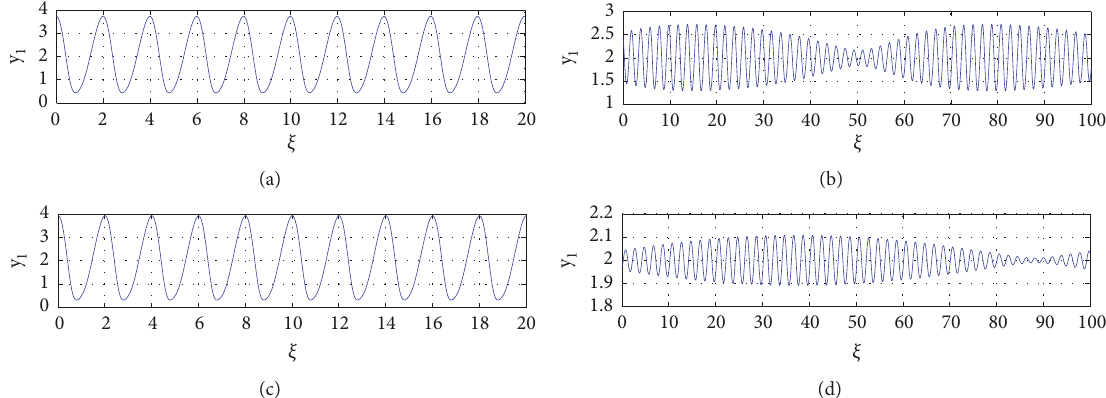
Figure7:Stablesolutionsof(28a),(28b),(28c),(28d),and(28e)obtainedbynumericalcalculationsafterdiscardingsufficientlylongtransients presented as time series; throughout 𝑎 = 4, 𝑏 = 15, 𝑉 𝑝𝑙 = 2 , 𝑘 0 = 21.7, 𝜀 = 0.1 for (a) and (b); 𝑘 0 = 21.95, 𝜀 = 0.136 for (c) and (d).